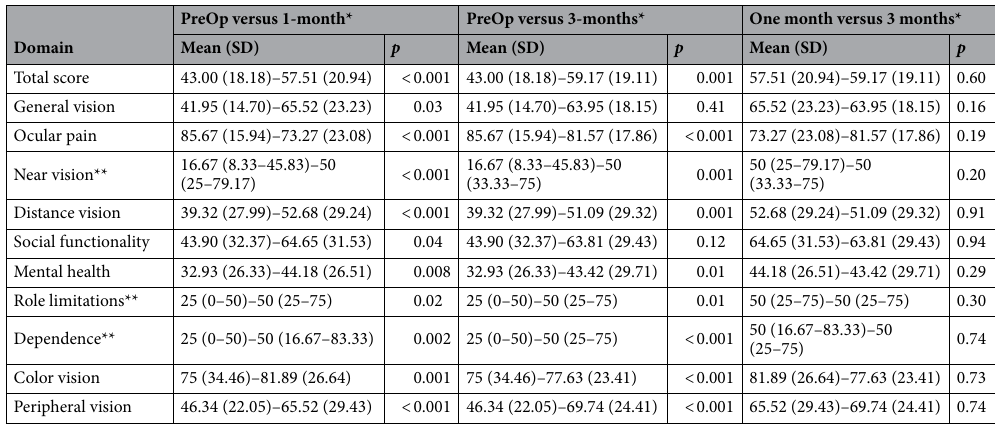
Table 1. Comparison of quality-of-life related variables of pre-and post-surgical evaluations, in advanced diabetic retinopathy. PreOp Preoperative. *Paired student’s t-test. **Wilcoxon’s t test.